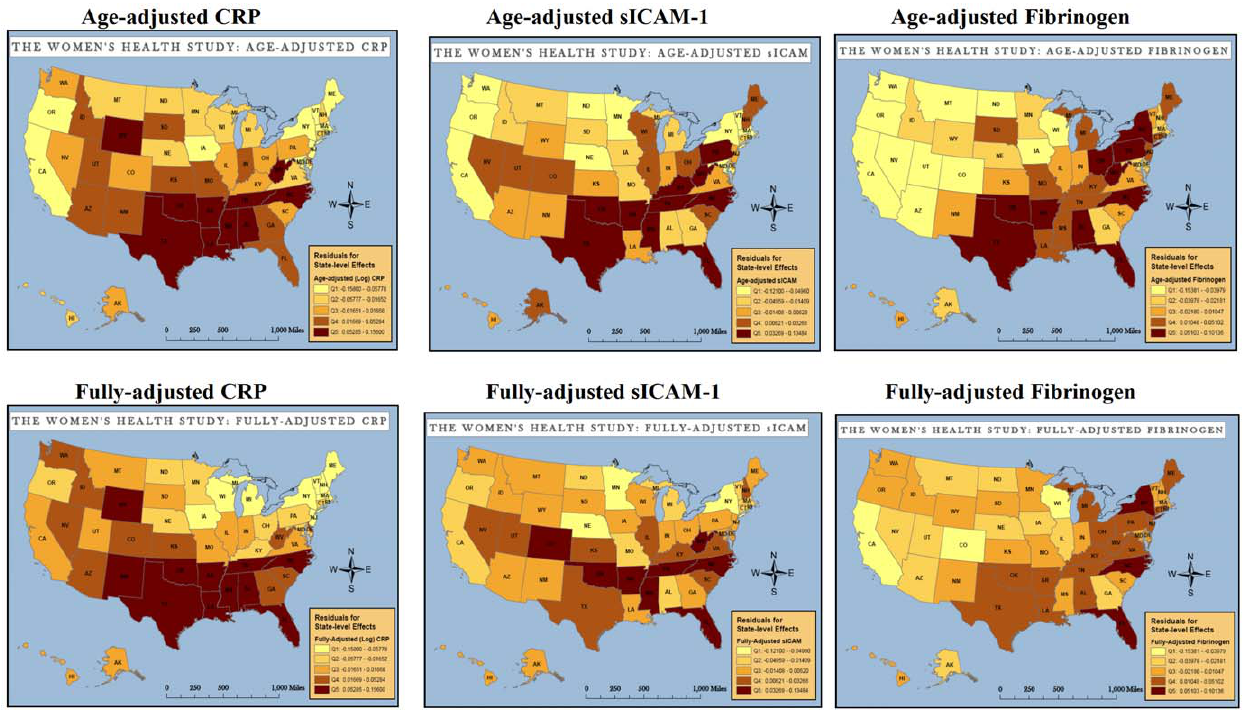
Figure 1. State-level Variation in Cardiovascular Biomarkers of Inflammation in the Women’s Health Study. Source: Women’s Health Study Participants. Abbreviations: Q1: Lowest quintile of inflammation; Q5: Highest quintile of inflammation. Fully-adjusted models include: age, race/ ethnicity, obese/overweight status, systolic blood pressure, diabetes status, HDL-C, LDL-C, smoking, exercise, caloric intake.